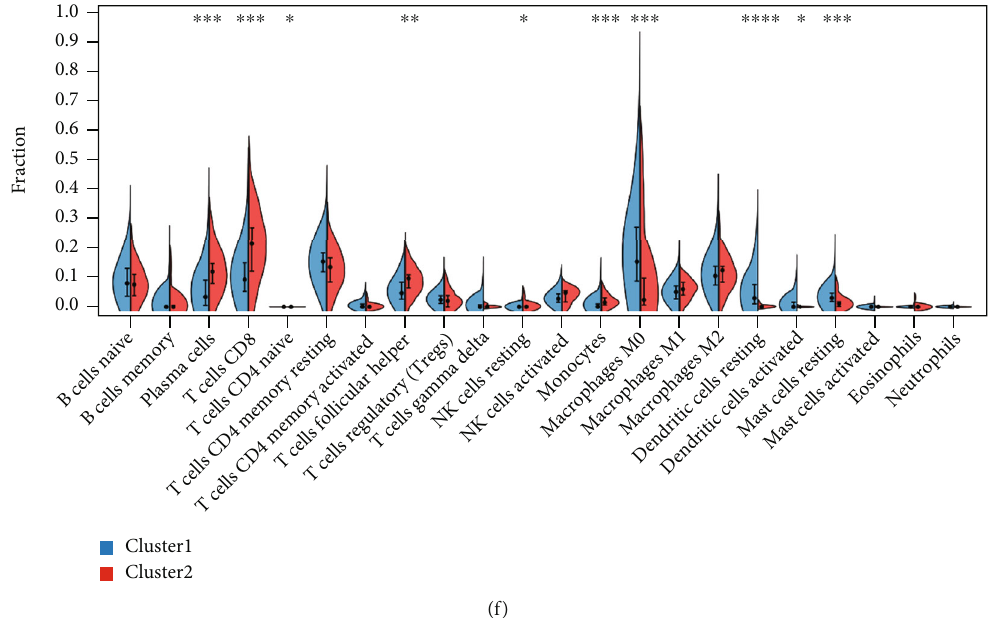
Figure 3: Immunity analysis of clusters. (a, b) Di ff erential expression analysis of immune checkpoints: (a) PD-L1 and (b) CTLA4. (c, d) Correlation plots between 11 Ferr-related lncRNAs and PD-L1 or CTLA4. The “ ∗ ” represents the statistically signi fi cant P value < 0.05, ∗∗ P < 0 : 01 , ∗∗∗ P < 0 : 001 , and ∗∗∗∗ P < 0 : 0001 . Red color represents positive correlation, while blue color represents negative correlation. The depth of colors represents the correlation value, ranging from-1 to 1. (e) Correlation between clusters and immune or stromal scores. (f) Violin diagram of TIICs distribution for two